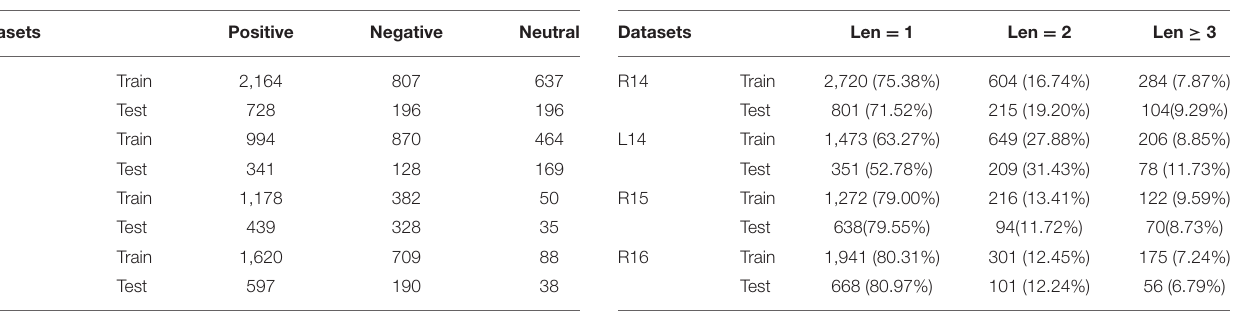
TABLE 1 | Samples of semeval 2014–2016 datasets. TABLE 2 | The numbers of terms in statistical